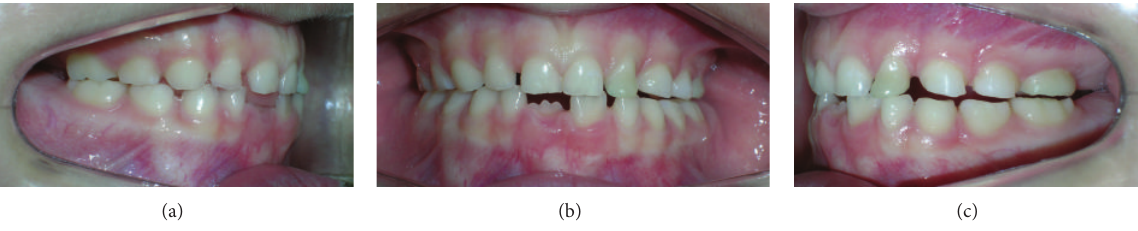
Figure 5: Clinical aspects after six months of treatment. (a) right side, (b) front view and (c) left